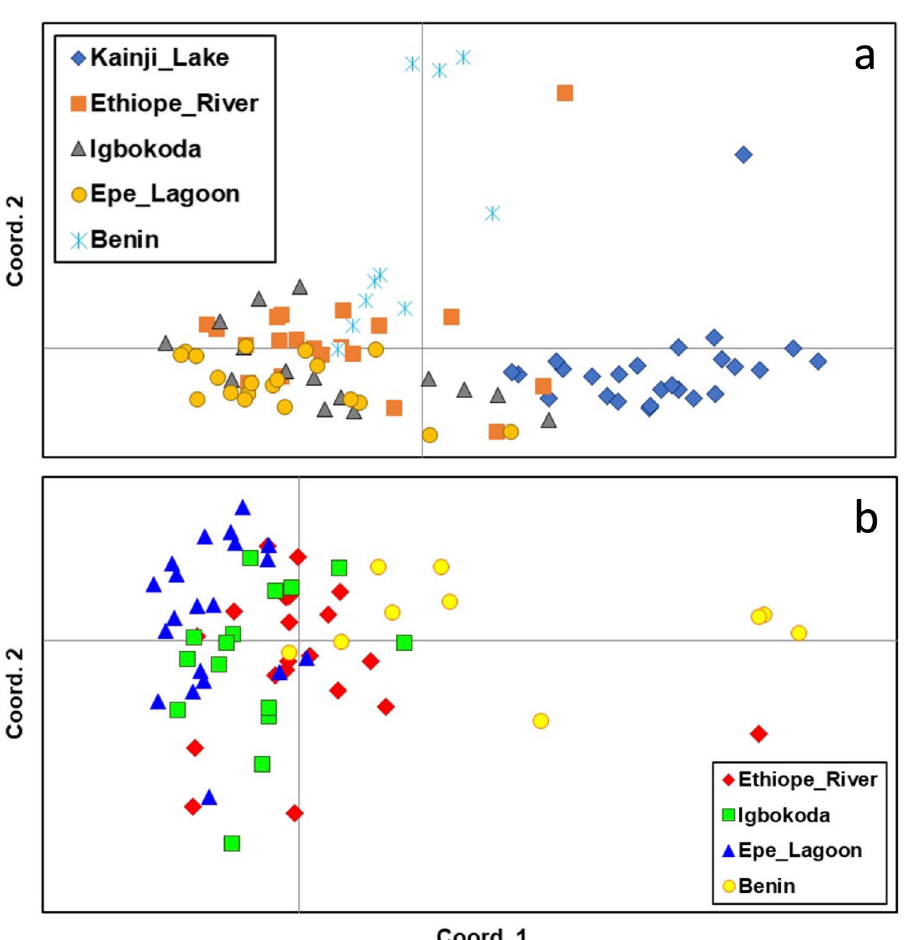
Figure 4. Principal coordinate analyses (PCoA) based on pairwise genetic distances of individual multilocus genotypes (individuals are color-coded by sampled population and plotted on the first two coordinates): ( a ) including all individuals from the five sampling locations; ( b ) excluding individuals from Kainji